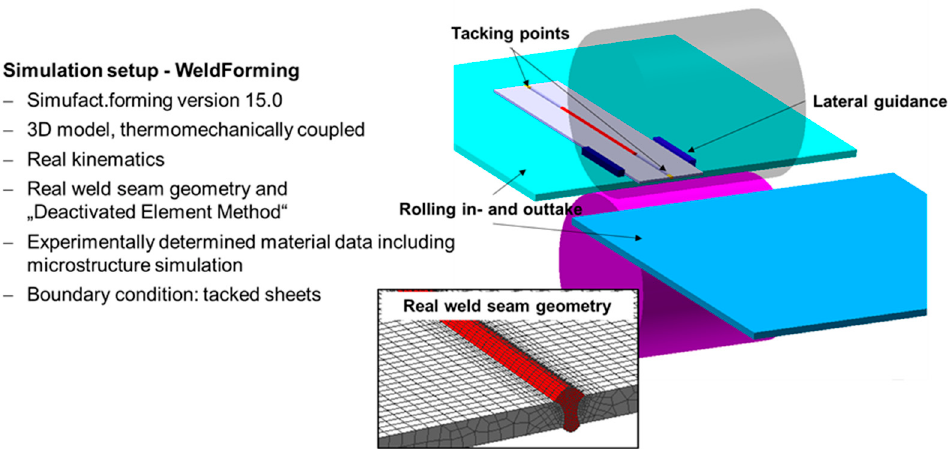
Figure 18. Summary of the simulation setup for WeldForming.